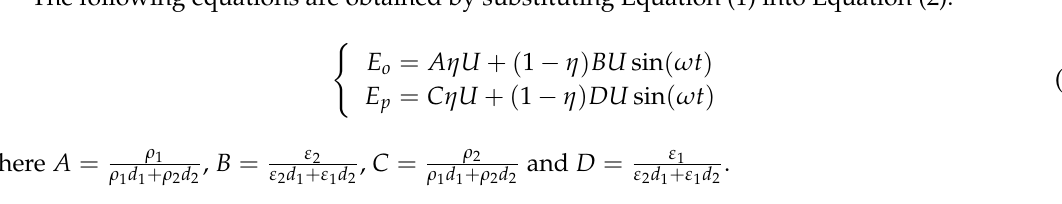
Figure 8. Equivalent circuit of oil-pressboard insulation.